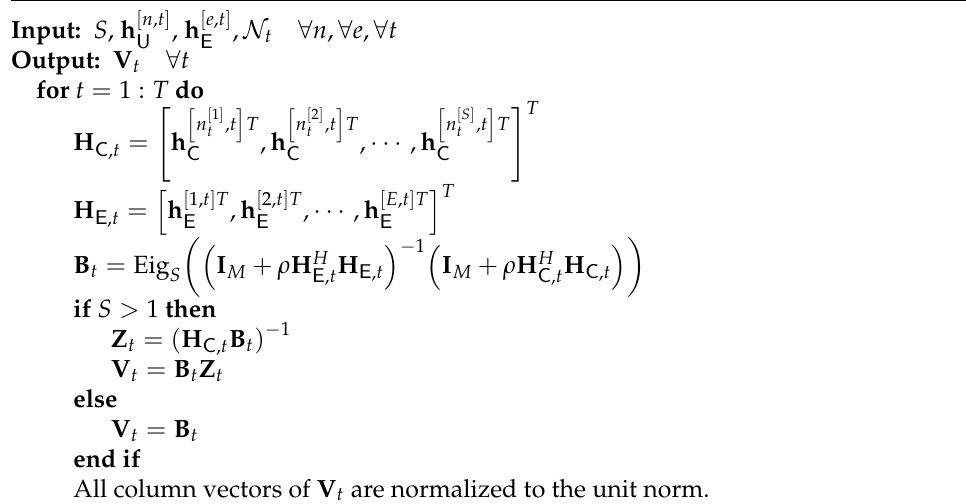
Algorithm 2 Transmit beamforming design at the base station (BS) for all time